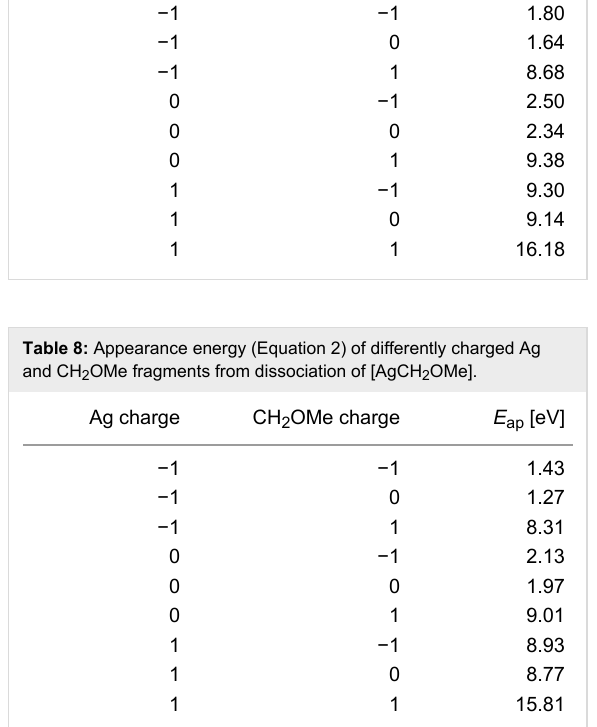
Table 7: Appearance energy (Equation 2) of differently charged Ag and CH 2 OMe fragments from dissociation of [AgCH 2 OMe] − . Ag charge